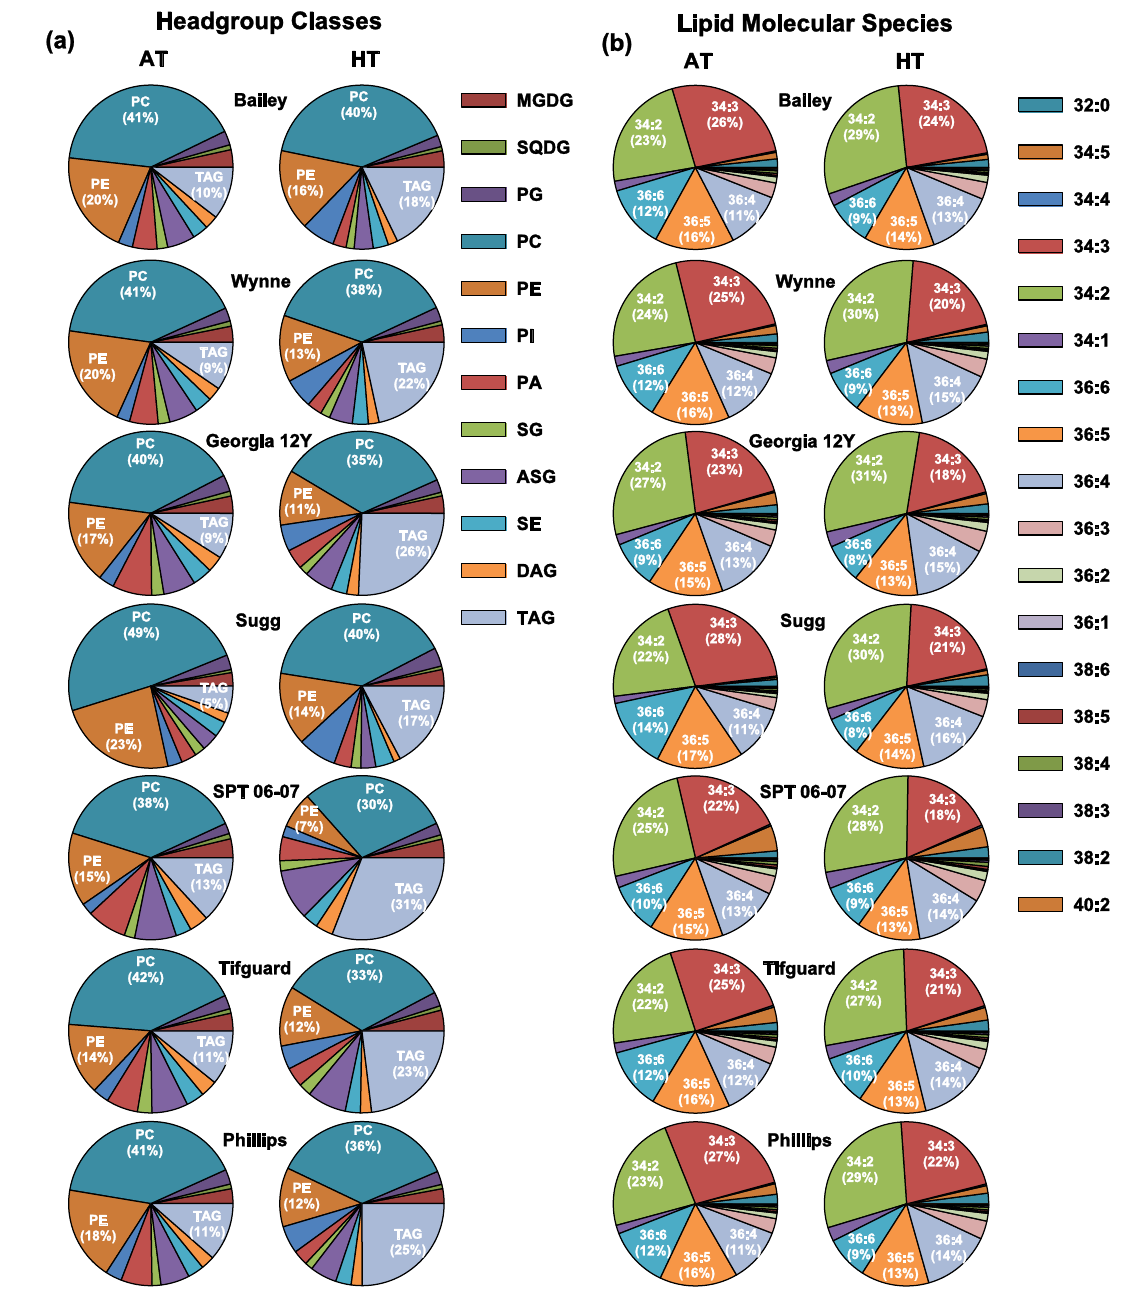
Figure 2. Pie charts representing composition of various lipid headgroup classes ( a ) and lipid molecular species ( b ) in peanut anthers under ambient temperature (AT, 31/22 °C for 2018 and 28/22 °C for 2019; average day/night temperatures during the 17-days and 18-days treatment periods in 2018 and 2019, respectively) and high temperature (HT, 41/27 °C for 2018 and 38/26 °C for 2019). ASG, acylated sterol glycoside; DAG, diacylglycerols; MGDG, monogalactosyldiacylglycerol; PA, phosphatidic acid; PC, phosphatidylcholine; PE, phosphatidylethanolamine; PG, phosphatidylglycerol; PI, phosphatidylinositol; SE, sterol ester; SG, sterol glycoside; SQDG, sulfoquinovosyldiacylglycerol; TAG, triacylglycerol. Lipid molecular species are identified as total acyl carbons: total double bonds. Data from 2 years (2018 and 2019) were pooled together for